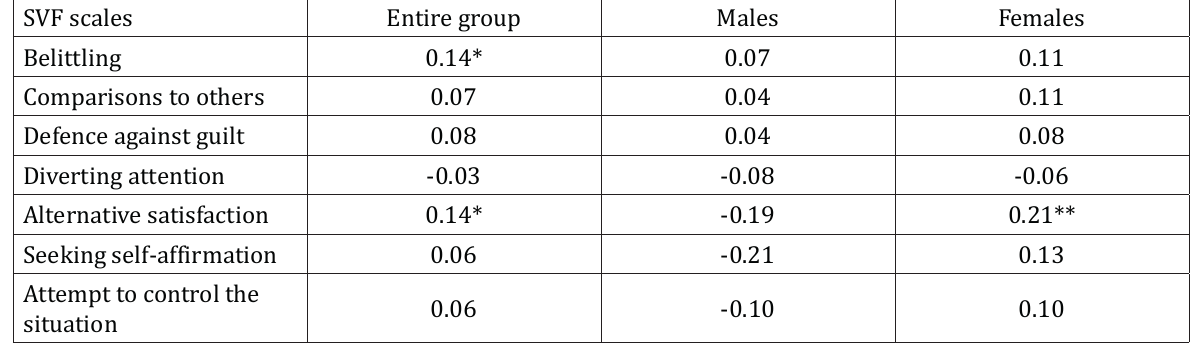
Statistically significant associations were found between longer SNS usage times in boys and their increased need for deference. Table 3. Correlation coefficients between the participants' daily SNS usage times and their SVF scores